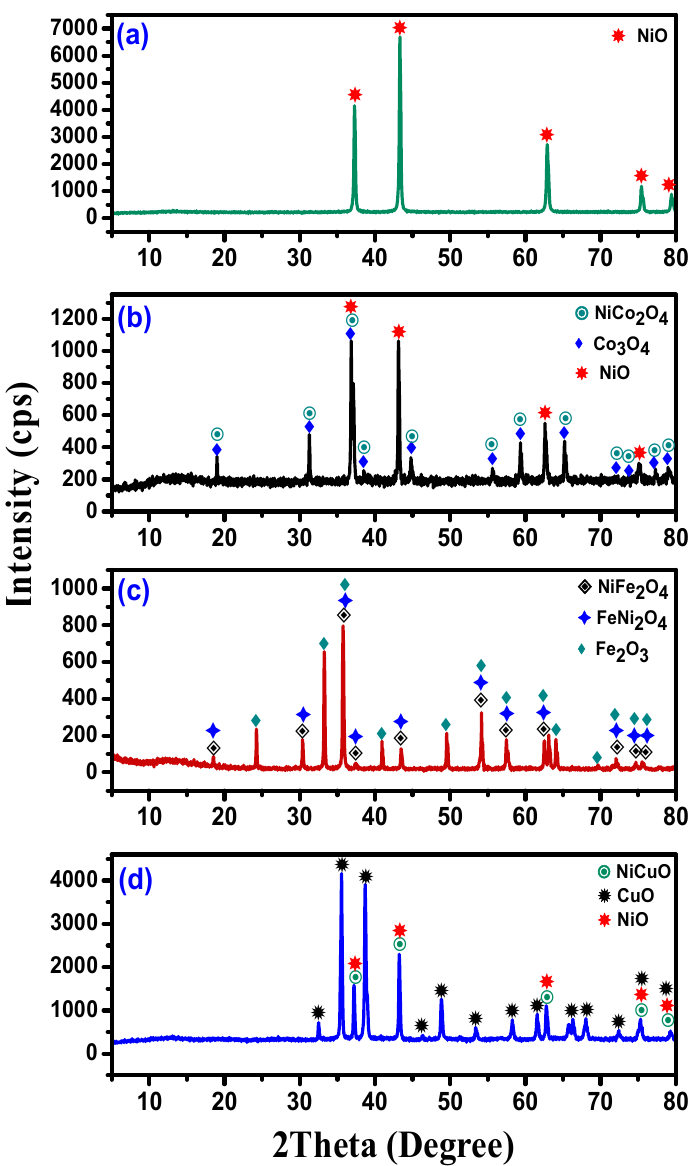
Figure 1. XRD patterns of the fresh samples: ( a ) Ni, ( b ) Ni-Co, ( c ) Ni-Fe, and ( d ) Ni-Cu.